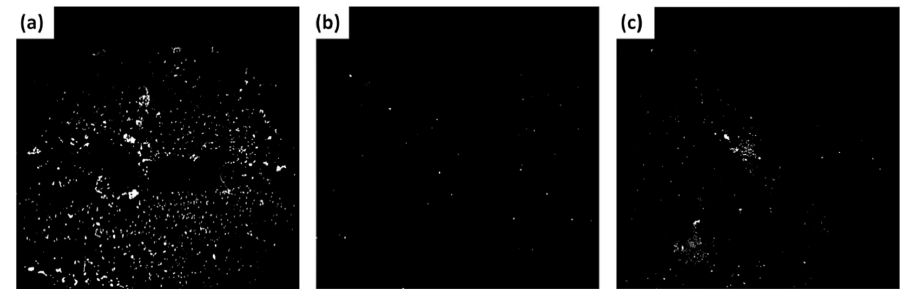
Figure 7. Fluorescence images of ( a ) porous gold substrates with antibody and exosomes; ( b ) porous gold substrate with exosomes only, without CD63 antibody (control); ( c ) nonporous gold substrate with antibody and exosomes (reference).